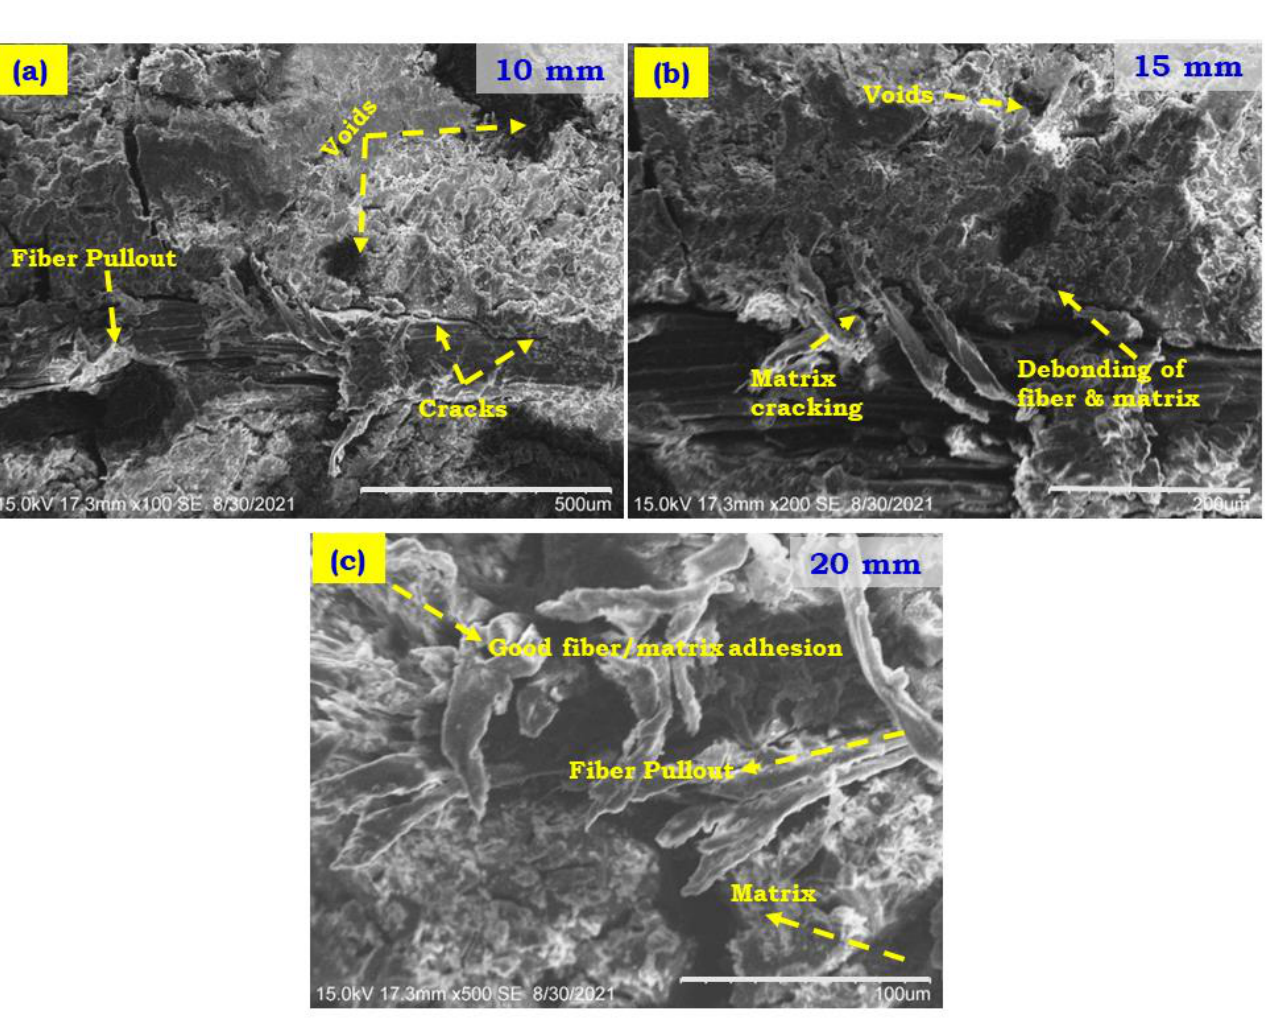
Figure 11. SEM morphologies tensile fractured surfaces of fiber length possessing 10, 15, and 20 mm. Figure 12a–c explains the multi-cellular nature corresponding to silane-treated PALF.